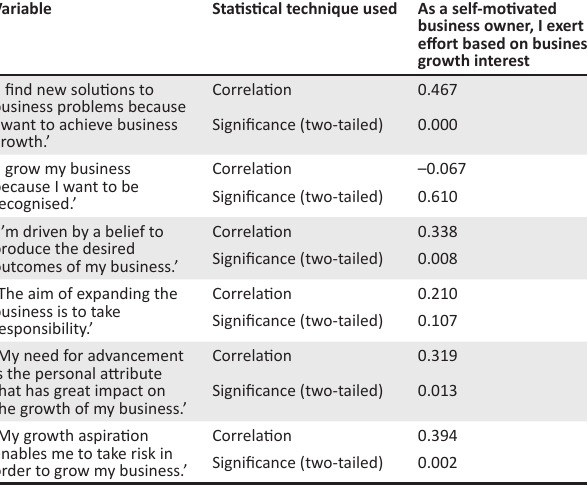
TABLE 7: Correlation tests of intrinsic motivational factors for business growth. Variable